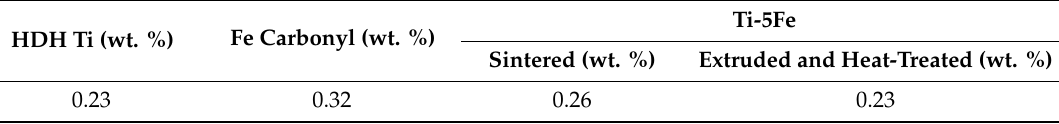
Table 1. Oxygen Content of the Ti and Fe Starting Powders and of the Sintered and Extruded Powder Metallurgy (PM) Ti-5Fe